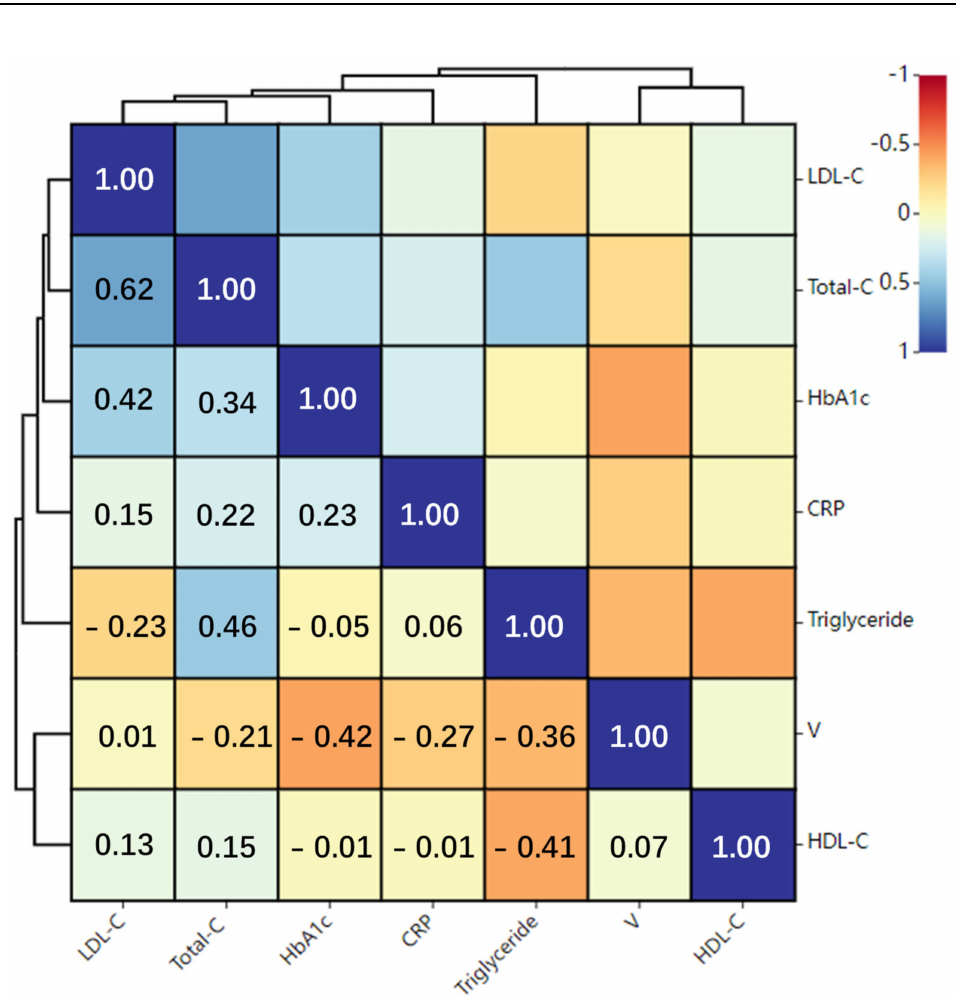
Figure 9. Correlation analysis of cell migration speed with physiological